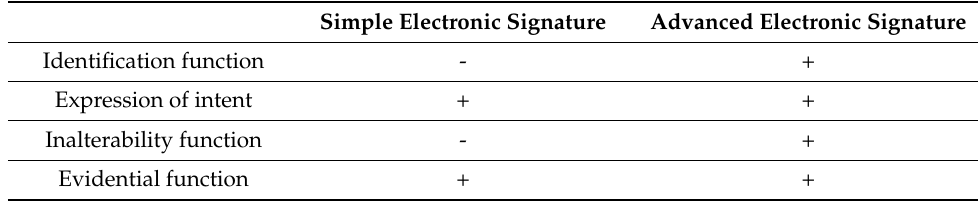
Table 2. Functional symmetry comparison of SES and